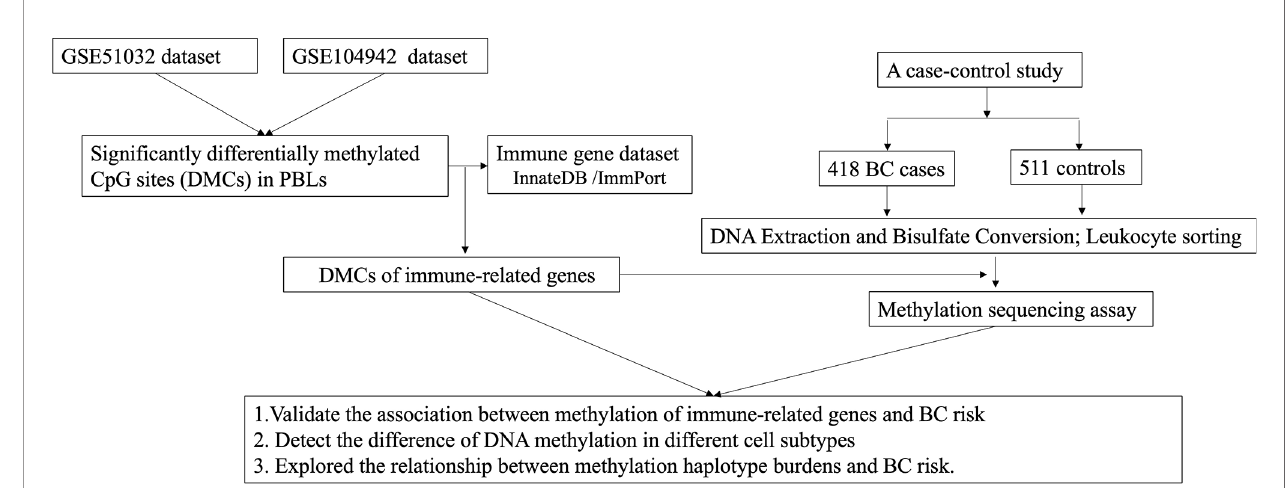
FIGURE 1 | Flow chart of the